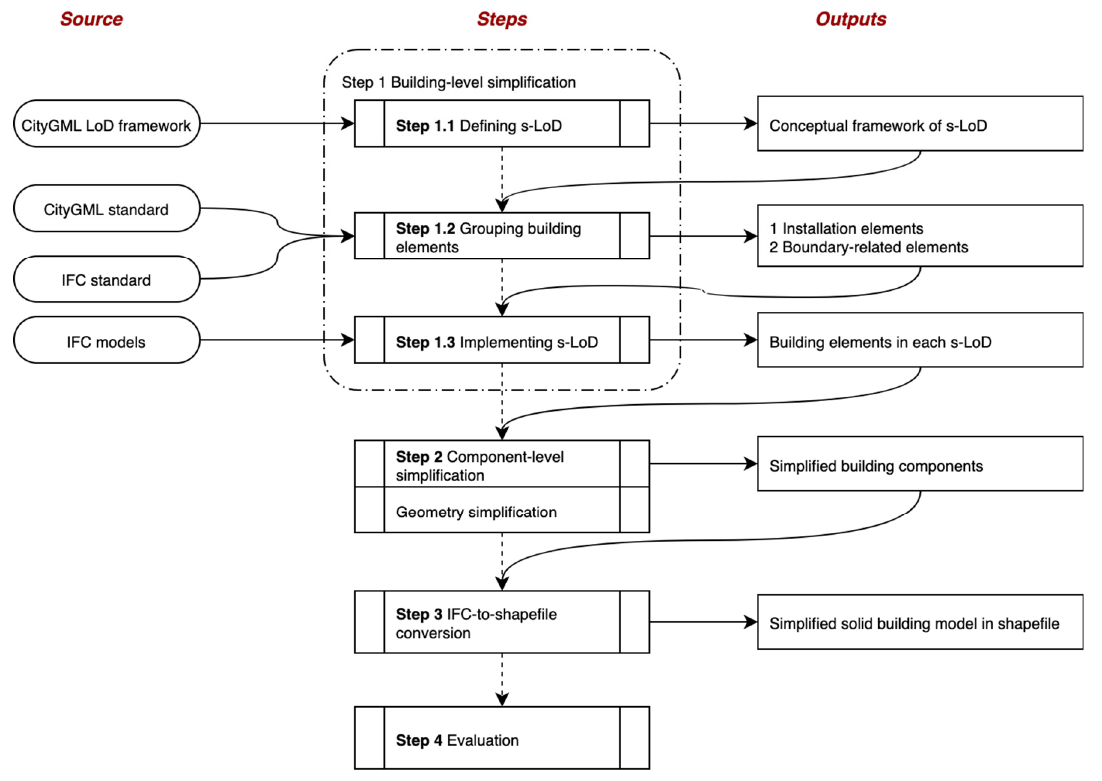
Figure 3. The overall framework for solid building simplification.